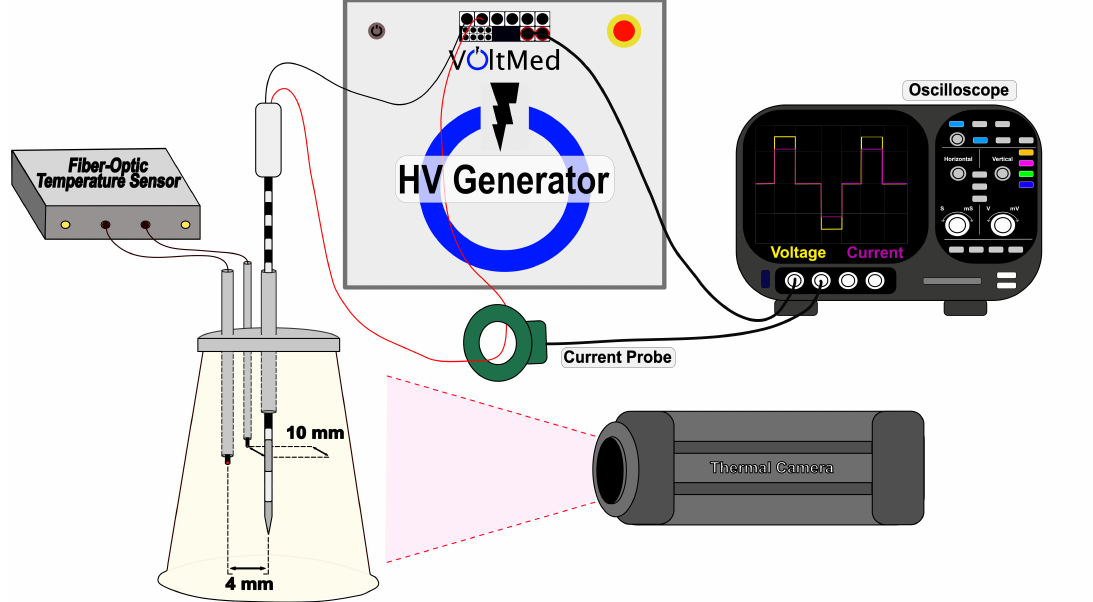
Figure 1. Schematic of the physical experimental setup for recording temperature and impedance measurements during treatment delivered from a high-voltage (HV) generator. A custom 3D printed electrode and fiber-optic temperature holder was fit on top of the agar tissue phantom. Two fiber-optic temperature probes were fed into the canals at a distance of 4 and 10 mm away from the electrode surface. Impedance measurements were calculated from voltage and current measurements collected on the oscilloscope. A thermal camera was placed at a distance 25 cm from the flat edge surface of the tissue